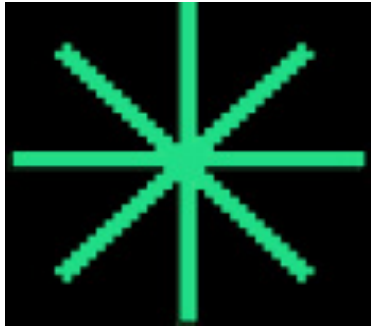
Figure 10. Spatial structure of Star8 (Visuality Graph, DepthmapX).